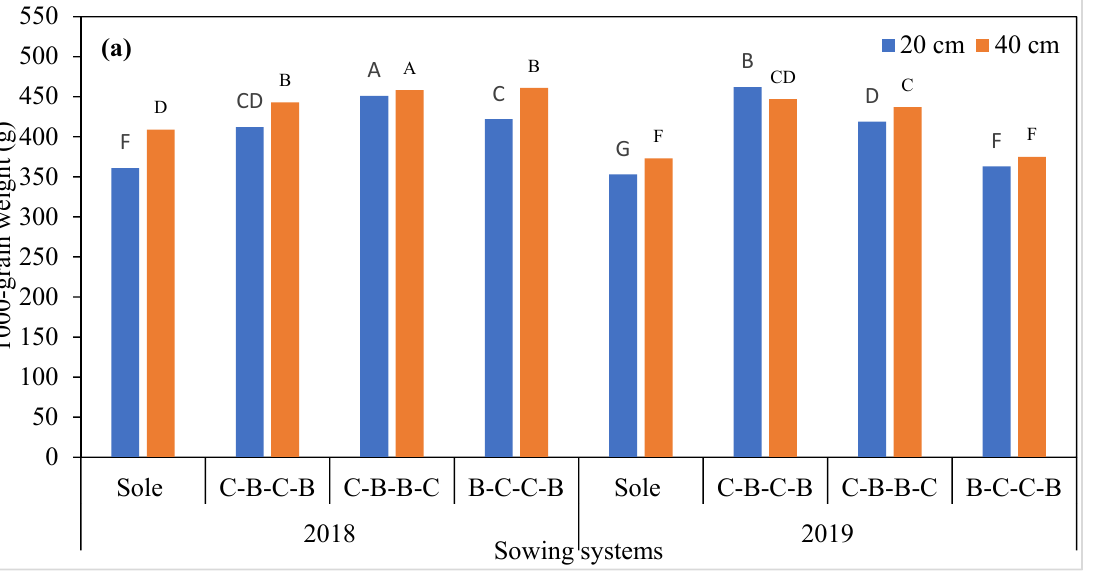
3 Figure 5. The interactions of maize–white bean sowing systems on 1000- kernel weight ( a ), grain yield ( b ) and protein ratio ( c ) at Nur Sultan, Kazakhstan research station. Letters on each bar represent a significance level